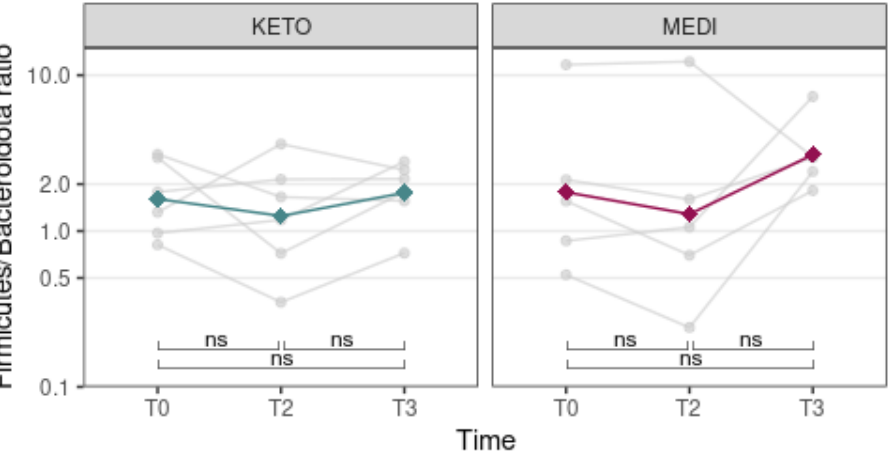
Figure 7. Gut microbiota Firmicutes/Bacteoroidota ratio comparison between time points for each diet. Each subplot concerns a different diet (KETO or MEDI). Samples from the same patient are linked by a gray line. The colored lines depict the mean values at each time point. A log 10 y-axis was used. Statistical significance was evaluated by the paired Wilcoxon signed-rank test, and it was indicated as follows: ns, non-significant. KETO = 6 patients who followed a very-low-calorie ketogenic diet (VLCKD), MEDI = 5 patients who followed a low-calorie Mediterranean diet (MD). Samples were analyzed at baseline (T0), after two months (T2), and after three months (T3) of nutritional